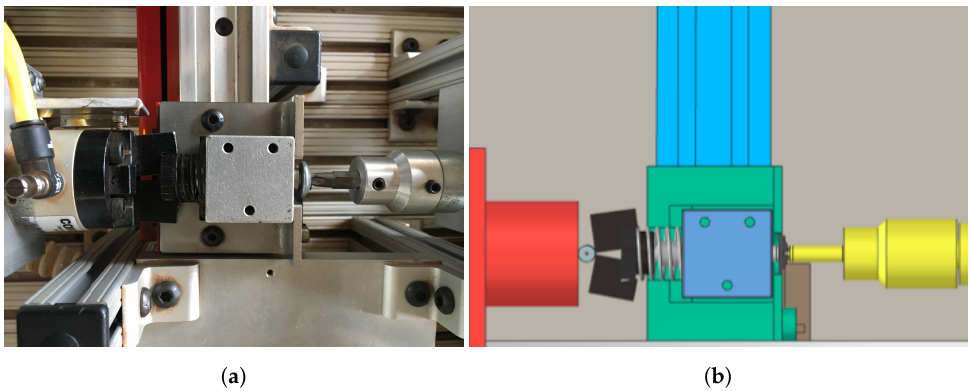
Figure 13. ( a ) machine, clamp close; ( b ) virtual model, clamp